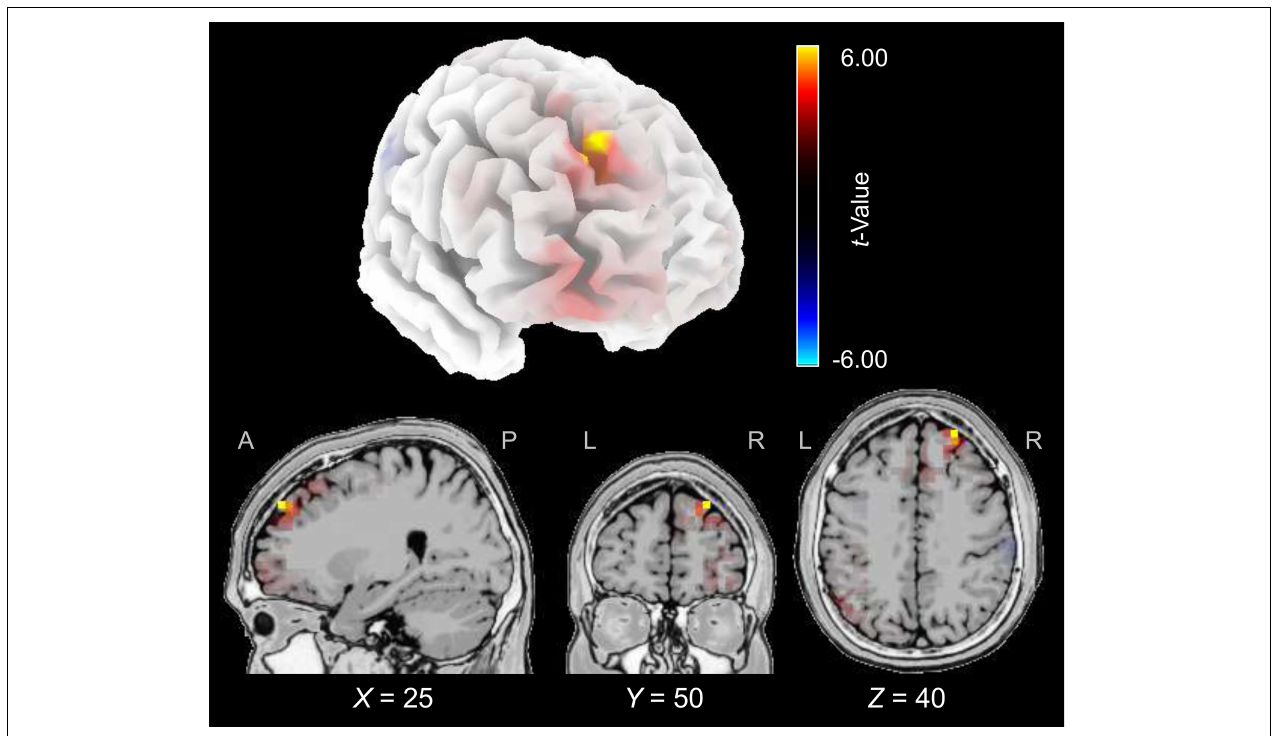
FIGURE 5 | Electrical brain activity at the time of the N2 after audiovisual-congruency training in the younger group. Electrical activity as revealed by sLORETA in the post-block was normalized with reference to pre-training activity and the resulting difference values were contrasted against the related difference values for the control condition. Data were mapped onto a standard 3-D brain template (top) or onto sagittal, coronal, and horizontal slices (T2 MNI-template “Colin 27” of sLORETA) positioned at X, Z, and Y coordinates (MNI) as given in the figure (bottom). Color coding shows t -values, with warm colors indicating increase of electrical activity and cold colors indicating decrease of electrical activity after training intervention (peak activity: t = 6.45, p = 0.005).